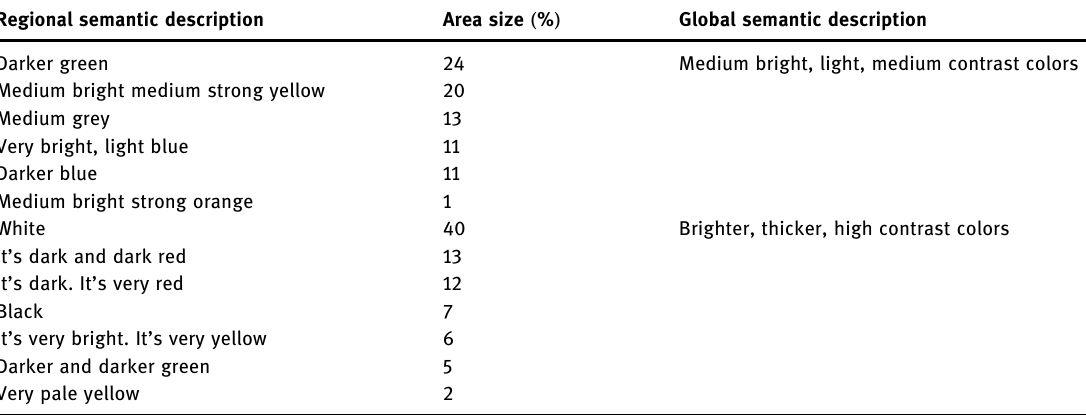
Table 3: Example of image semantic description Regional semantic description